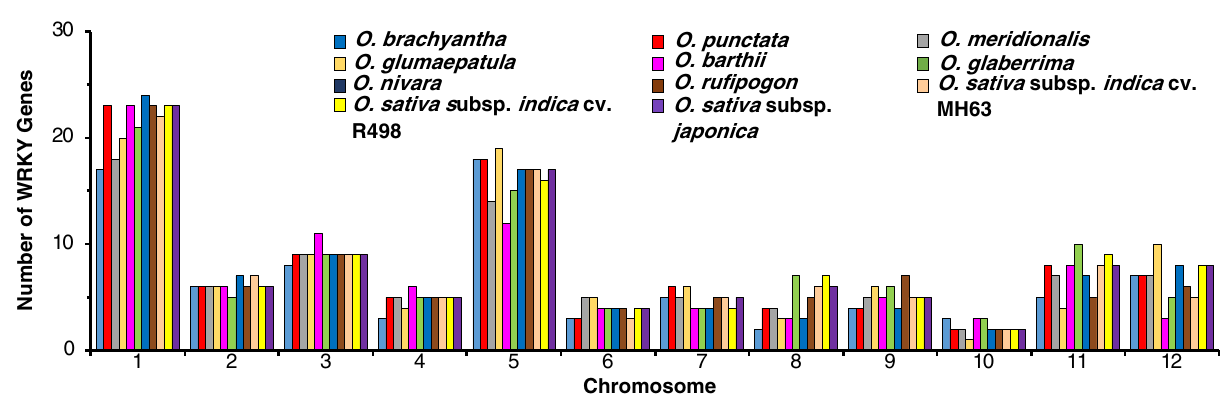
Figure 1. WRKY gene distributions are consistent across Oryza . On average, chromosome 1 contains the greatest number of WRKY genes (24%), chromosome 5 contains 17% of total identified WRKY genes and chromosome 10 contains the least number of WRKY genes (only 2%). Bar heights represent number of WRKY genes distributed across the Oryza genomes, bars are clustered per chromosome, colors indicate Oryza species genes are identified in. Ordered from left to right roughly based on